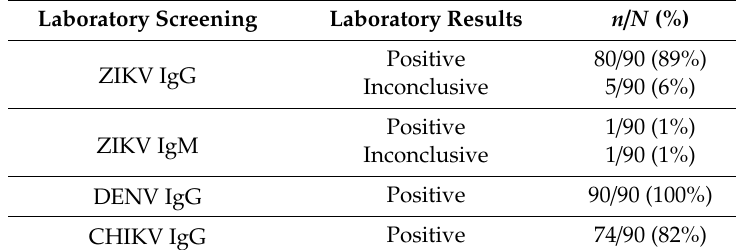
Table 2. Laboratory results of serum from pregnant women enrolled in the study in Ceret é , Colombia, 2016.